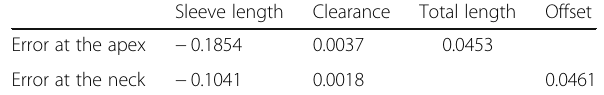
Table 5 Multiple regression coefficients ( p < 0.0005) Sleeve length